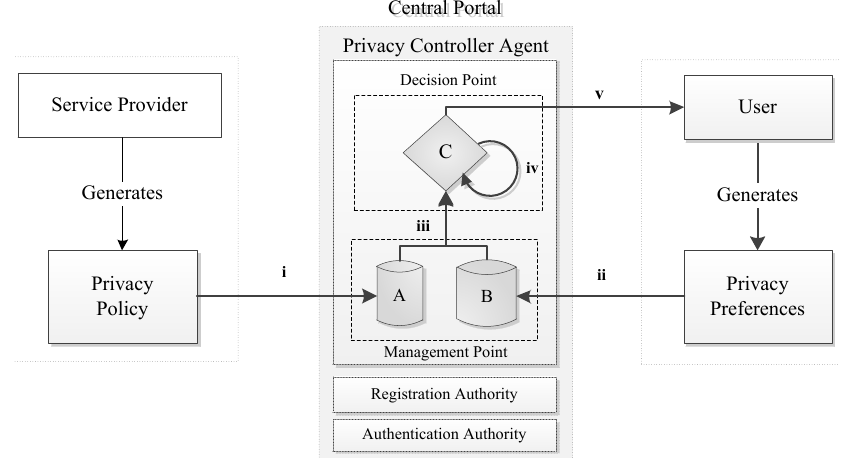
Figure 1. Privacy Controller Agent